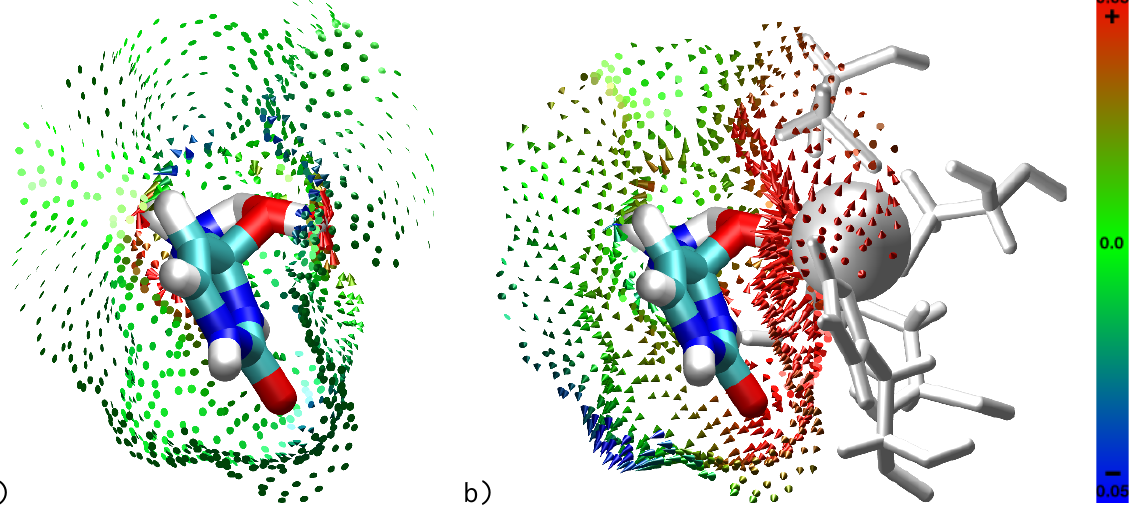
Figure 4: Differential transition state stabilization of the transition state by the cytidine deaminase active site. Only the four catalytic residues are shown but the DTSS properties were calculated using the active site model of 8Å radius. Significant electrostatic field is observed within the proximity of the zinc cation which seem to be responsible for drawing the ligand into the active site. a) the „idealized” catalytic environment – difference in MEP and MEF between S ‡ and S. b) the catalytic environment provided by the